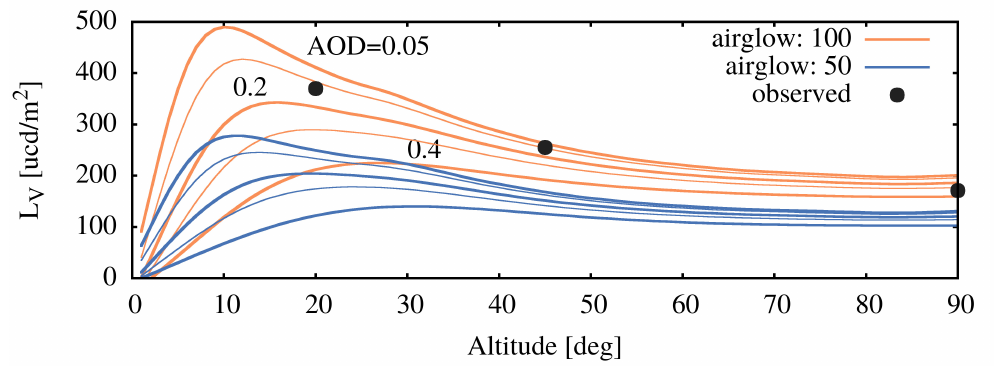
Figure 3. Airglow radiance as a function of altitude. The lines show the GAMBONS model for high (orange) and low (blue) level of activity. The models are provided for two different solar activity levels (50% and 100% in the GAMBONS calculator) and for AOD = 0.05, 0.10, 0.20, 0.30 and 0.40 (from top to bottom). The labels next to the thick orange curves provide the corresponding AOD values. The black dots represent the actual